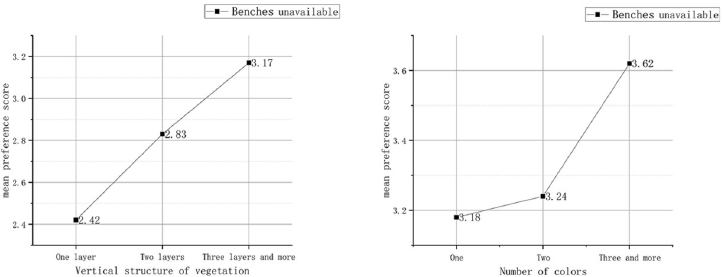
Fig 6. Preference evaluation under the influence of benches and plant factors